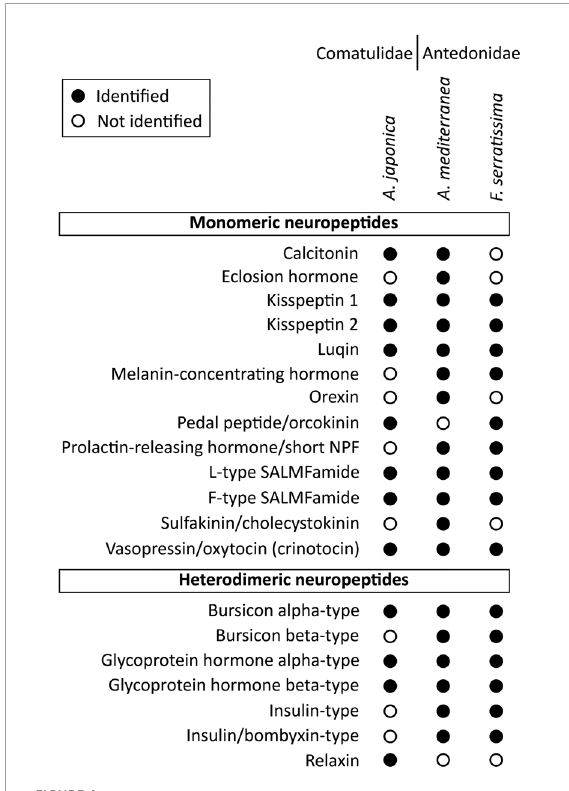
FIGURE4 Summary showing in which species the monomeric and heterodimeric neuropeptide precursors have been identified in this study. Filled circles represent cases where neuropeptide precursors were identified in a given species, whereas empty circles represent cases in which the precursors were not identified. Where neuropeptide precursors were not identified, this may reflect incomplete transcriptome/genome sequence data or loss in one or more species. The DNA sequences of transcripts encoding these precursors are shown in Supplementary File 2